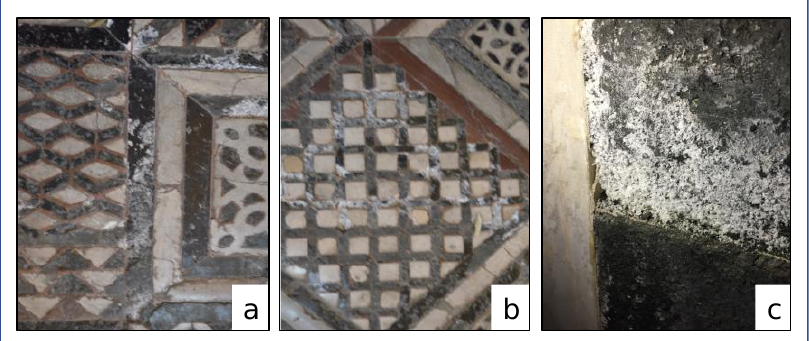
Figure 5. Details of the efflorescence on the serpentinite floor ( a , b ) and wall ( c ).